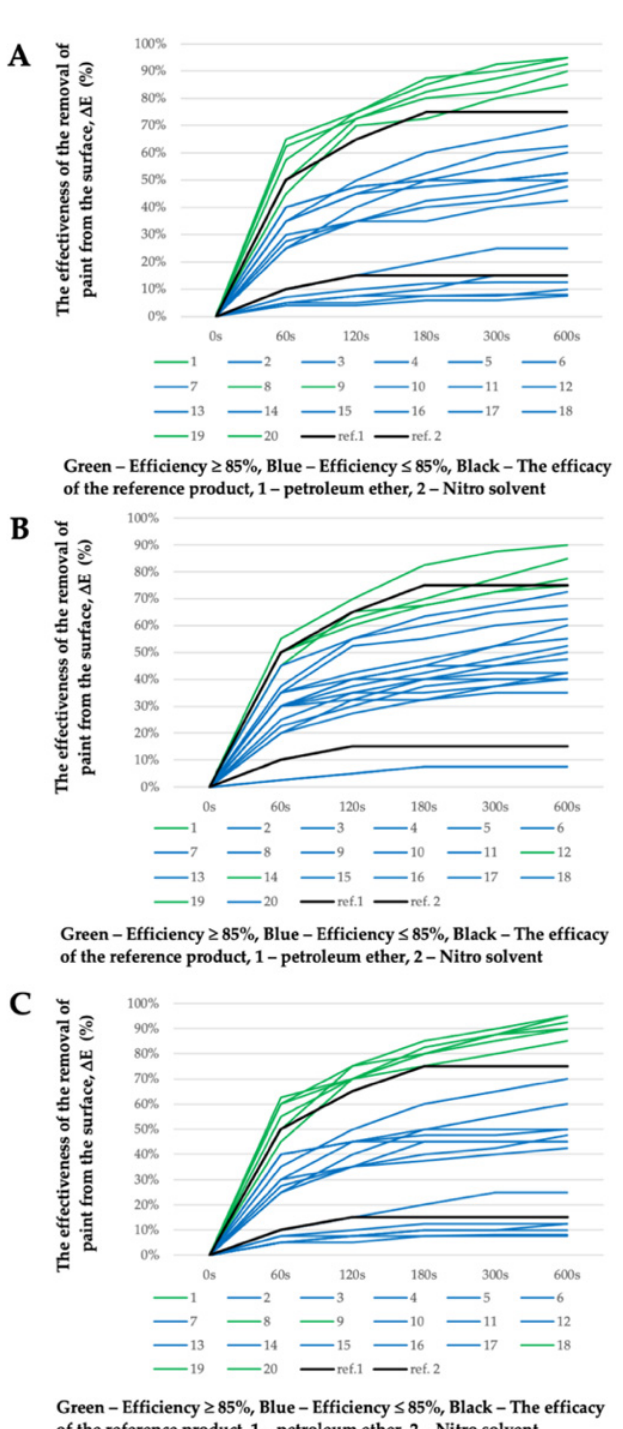
Figure 2. The effectiveness evaluation of the removal of graffiti paint from a surface ( ∆ E) in %; ( A ) graffiti remover formulations no. 1–20 based on MG-400-RO; ( B ) graffiti remover formulations no. 1–20 based on MG-400-SO; ( C ) graffiti remover formulations no. 1–20 based on MG-400-UCO.